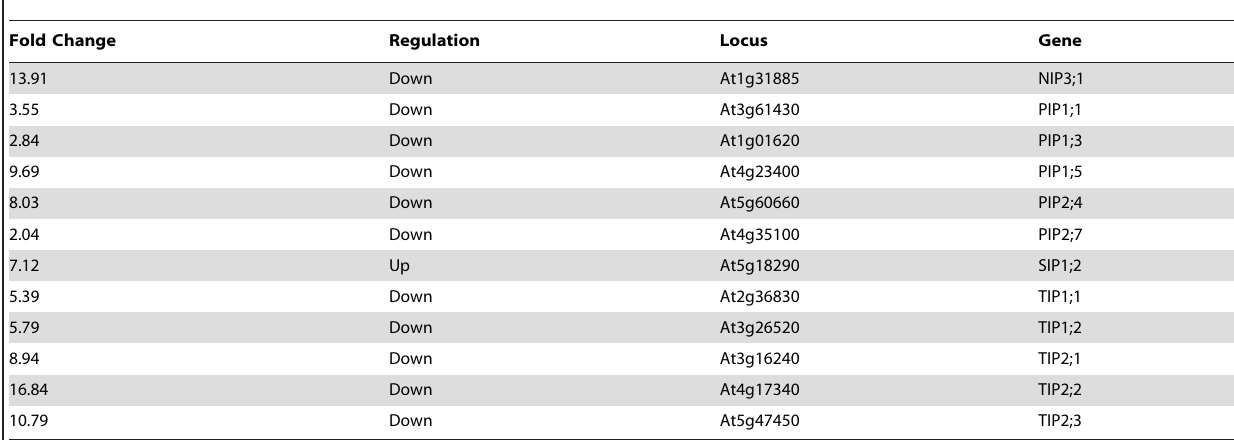
Table 6. Changes in regulation of aquaporins in response to